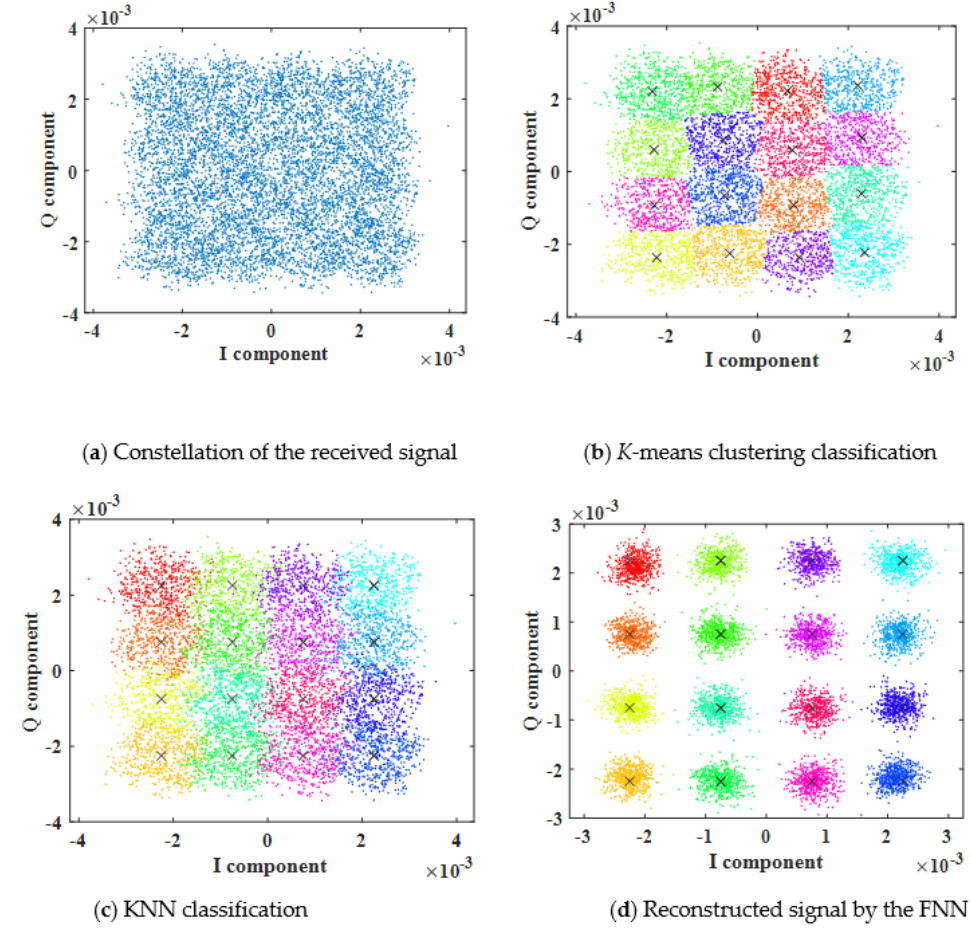
Figure 9. Constellation of the 16 − QAM signal before and after using ML techniques.